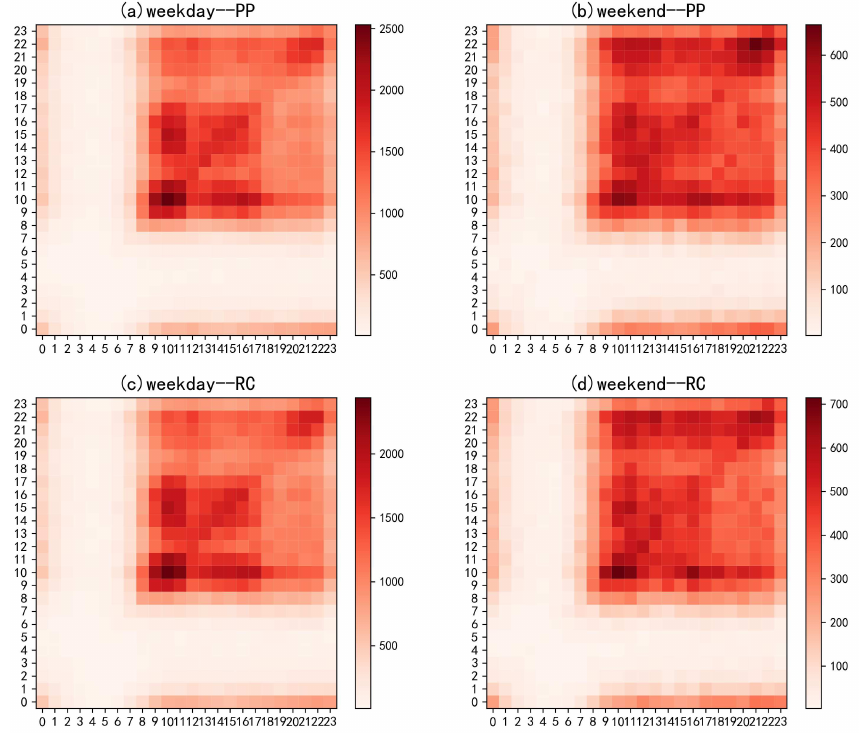
Figure A2. Different performances in periodic intervals between weekdays and the weekend, taking the sector Computers as an example. The meanings the of x -axis and y -axis are both corre- sponding with those in Figure 4. The identification standard of a weekday or weekend is according to PP time in subplots ( a , b ), while it is according to RC time in ( c , d ). The results of other sectors are the